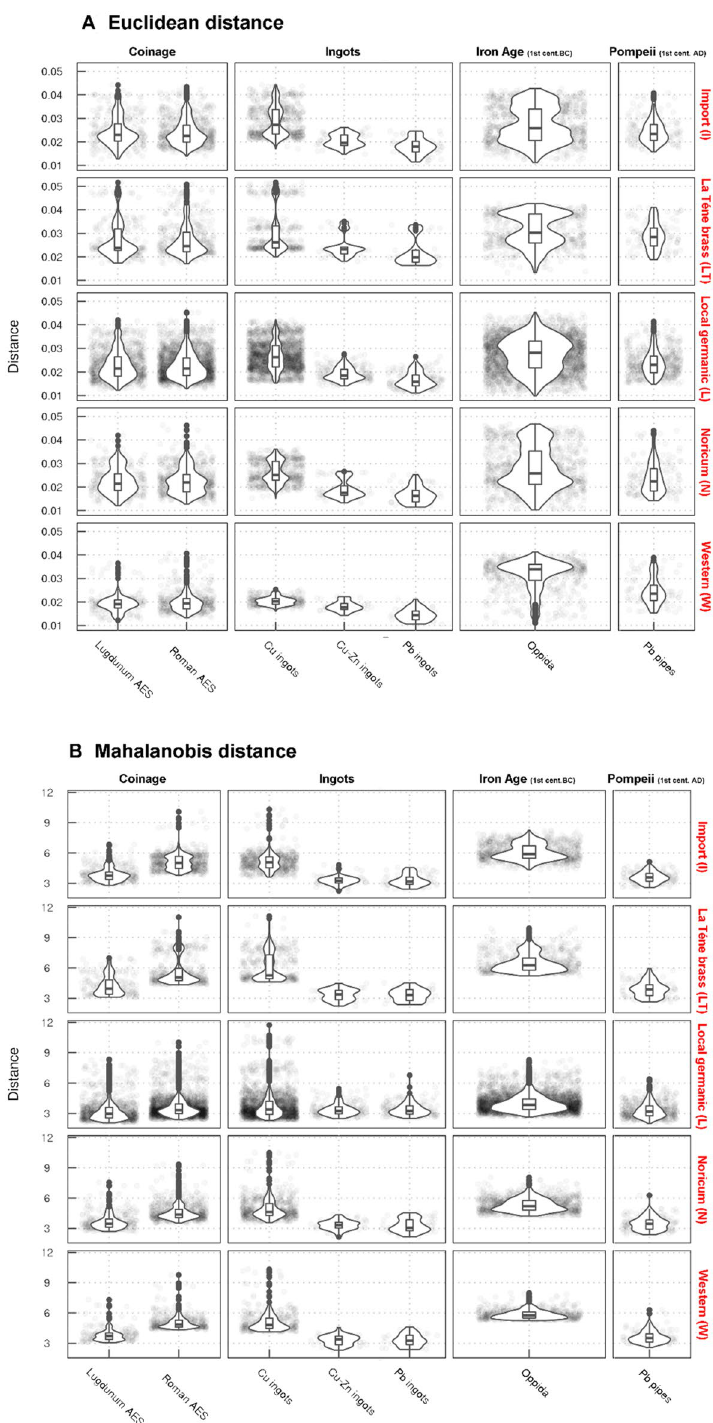
Figure 9. Euclidean (ED) and Mahalanobis (MD) distances between Pb isotope ratios of various sets of the analysed artefacts from the Early Roman period (red labels) and the comparative datasets of bronze and brass artefacts (coinage, ingots, Iron Age objects from the oppida, Pompeii objects; for references, see main text). The graph shows the density distributions (‘density violin plots’) according to their distance. Unlike ED, the MD distributions also take into consideration the shape of the data clouds and their trends. The closer to zero the higher the probability of the analytical match. Sources: see description in the main text + this